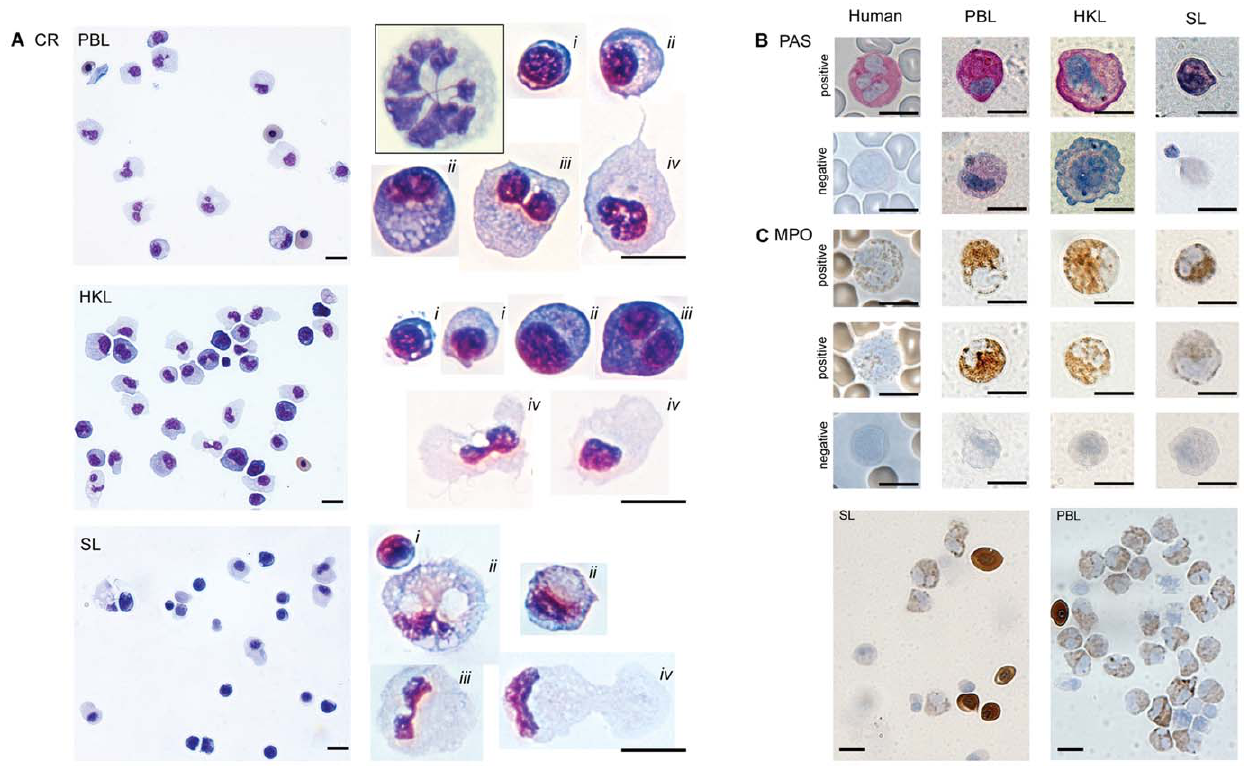
Figure 2. Morphological and cytochemical analyses of leucocytes isolated from peripheral blood, head kidney and spleen. Cytospin preparations of PBL, HKL, SL stained with Colorrapid (CR) (A), PAS (B) and MPO stained cells (C). The overview photos in A (left) and representative single cells (right), captured 630 6 magnifications. i =lymphocytes, ii =monocytes/macrophages, iii =polymorphonucear cells and iv =dendritic-like cells. The inset at top (right) in (A) show a polymorphonucleated cell (neutrophil) isolated from Atlantic salmon for comparison. In (B) and (C), representative single cells of isolated PBL, HKL and SL shown are captured at 630 6 . Representative cells from human blood smears are shown as controls (630 6 ). Note that PAS staining (B) was highly variable and the two negative cells shown for PBL and HKL might be considered weak positive. In (C), overview of MPO stained SL and PBL, captured at 400 6 , show positive and negative leucocytes. Erythrocytes stain MPO positive. Scale bars=5 m m.